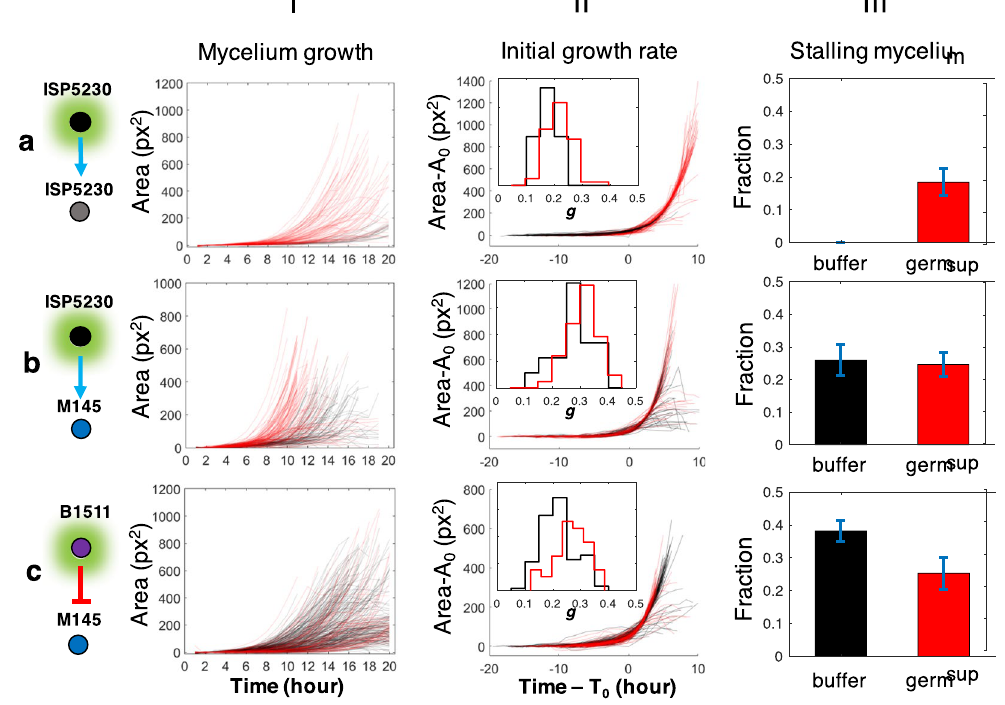
Figure 5. The effect of chemicals in germination supernatants on mycelium growth. The growth curves (I), the distribution of growth rates (II), and the stalling fractions (III) were compared between spores treated with germsup (red) or reference buffer (black) for three germination interactions shown in Fig. 4. The shown reference buffer is nutrient broth for the positive interactions and water for the negative ones. The area curves in (II) were aligned by shifting them along the time and area axes in order to compare growth after germination. The distribution of growth rates ( g ) is shown in the inset. ( a ) The germsup from fresh spores of ISP5230 that strongly promoted germination of aged ISP5230 spores (Fig. 4c) mildly increased growth rates (II) (p = 0.009). The fraction of stalling mycelium treated by reference buffer could not be determined due to the much-delayed germination (III). ( b ) The germsup of ISP5230 promoting the germination of M145 (Fig. 4b) did not affect the growth rate (II) or stalling fraction (III) of the M145 mycelium. ( c ) The germsup of B1511, which inhibits the germination of M145 (Fig. 4b), slightly but significantly increased growth rate (II) (p = 3 × 10 − 6 ) and decreased the stalling mycelium fraction of M145 (III) (p =